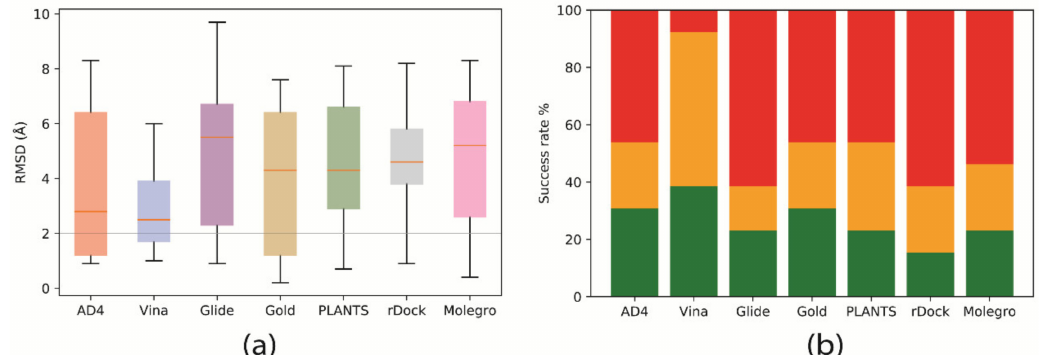
Figure 4. Distribution of the redocking results, and their corresponding ‘success rate’, for all programs. Only the top-scoring pose of each of the ten trials, was used to calculate the average. ( a ) A boxplot indicating the redocking accuracy in RMSD (Å). A line corresponding to the 2 Å RMSD cuto ff , a typical guide for measuring redocking success, is also provided for comparison. The orange line indicates the median result for each program. ( b ) A stacked bar chart illustrating the ‘success rate’ for each of the programs. The green, orange, and red areas correspond to the percentage of models that achieved a redocking score of ≤ 2.0, ≤ 4.5, and > 4.5 Å RMSD,